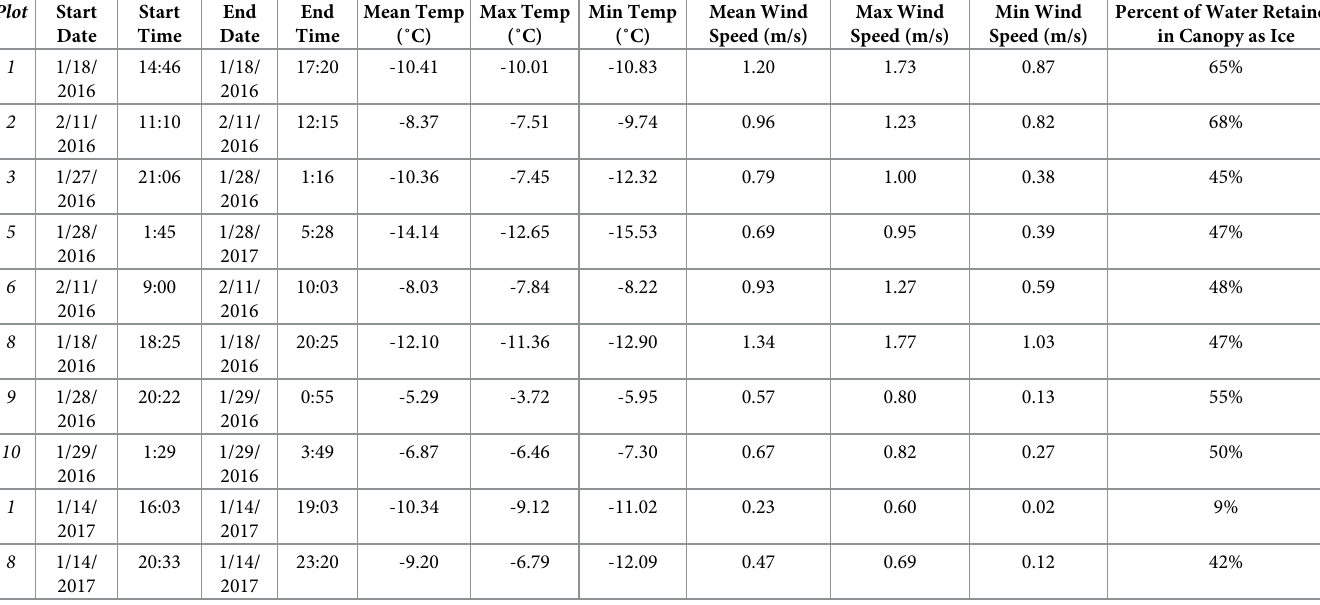
Air temperatures are from sensors at the plots; wind speeds are from Hubbard Brook Experimental Forest weather station 1, approximately 5 km from the treatment plots.